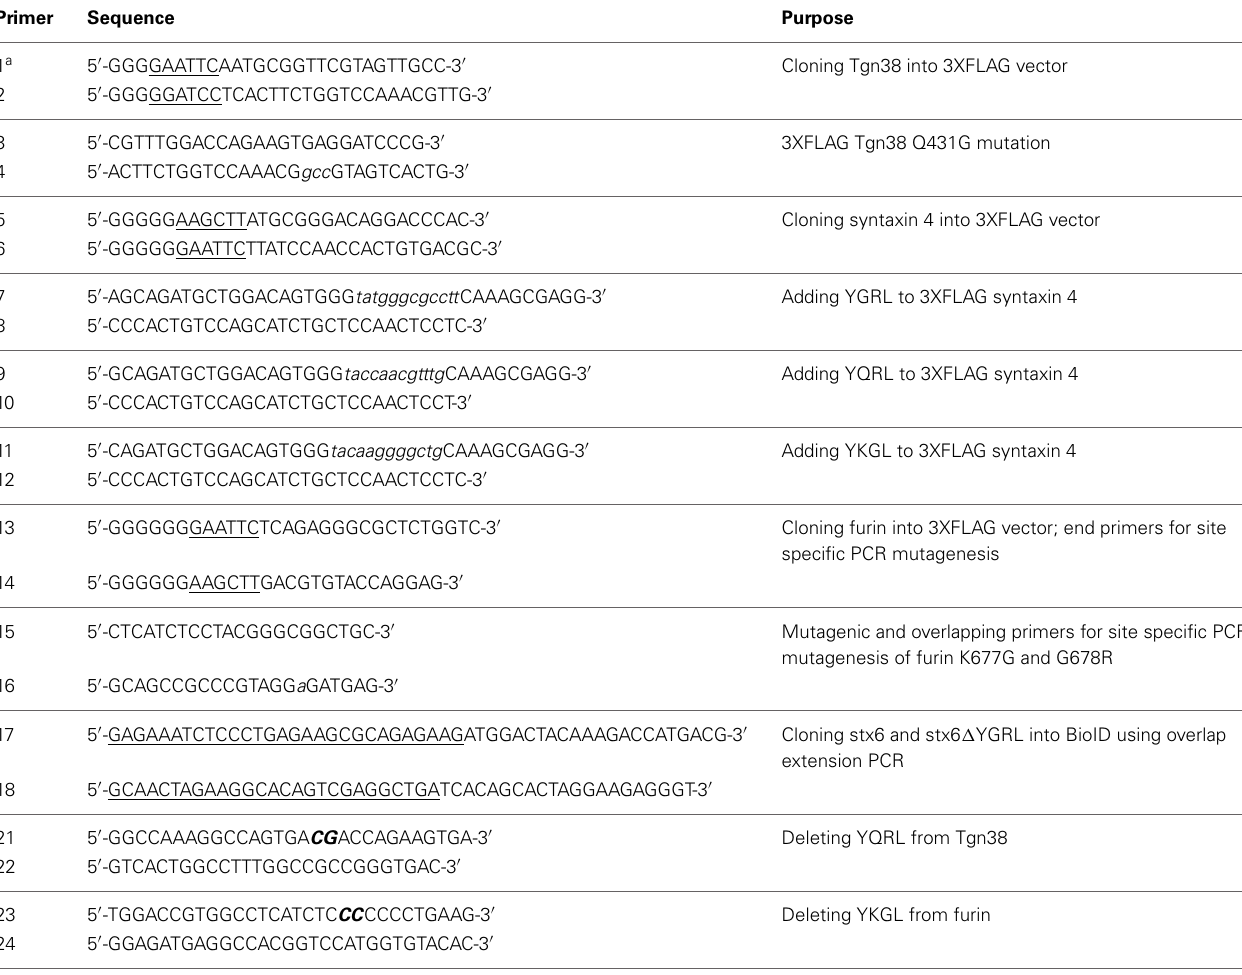
a All odd numbered primers are forward primers and all even numbered primers are reverse primers. Restriction sites are underlined. Mutated sequences are in lower case and italicized. Deletions are indicated with bold and italics on either side of the deleted sequence. For overlap extension PCR vector sequence is